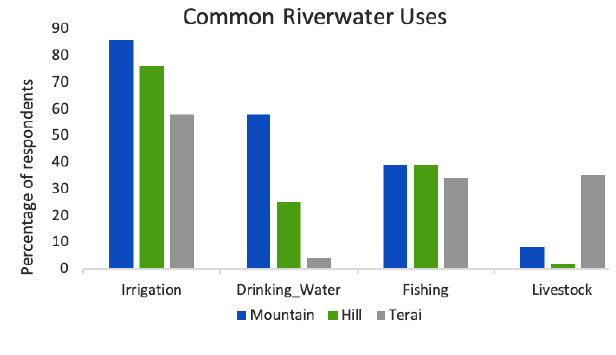
Table 1. Gender and ethnic composition of respondents from communities in three regions surveyed across the Karnali basin, Western Nepal.